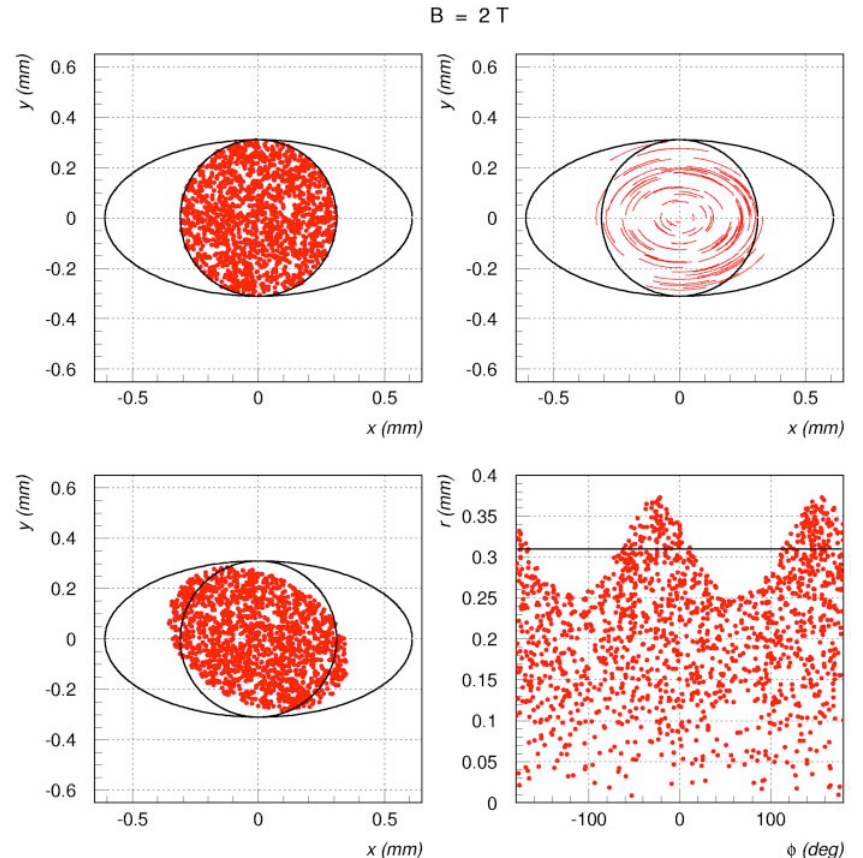
FIG. 3. (Color) Narrow electron beam distortion due to (cid:197) (cid:112)